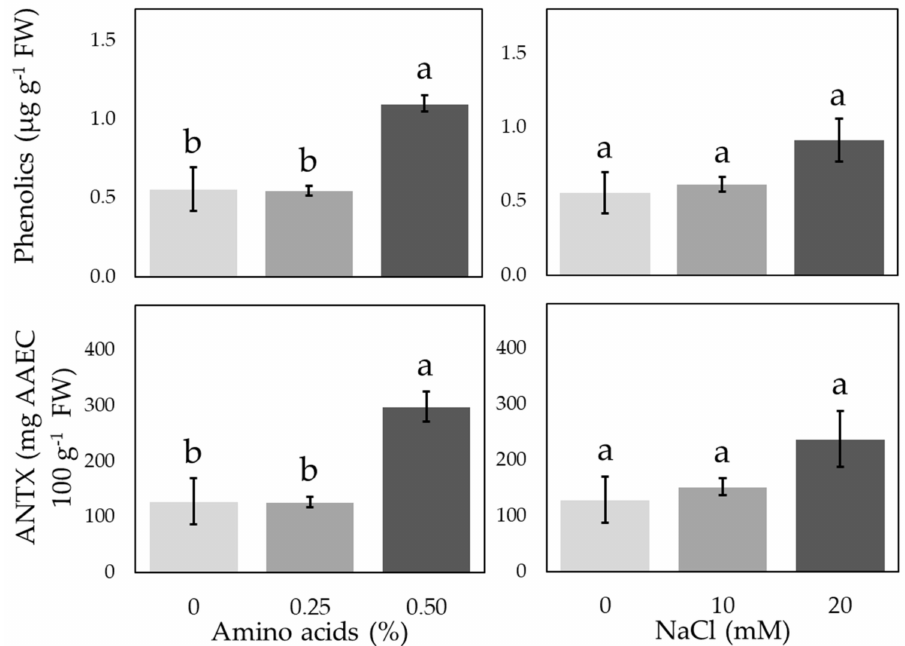
Figure 3. Soluble phenolic content and total antioxidant capacity (ANTX) of spearmint plants grown hydroponically in a floating system on a nutrient solution supplemented either with 0, 0.25 or 0.50% of a commercial amino acid solution (Amino16 ® ) or 0, 10 and 20 mM NaCl. Each column is the mean of 3 replications with 16 plants per replication. Different letters on the columns in each treatment (amino acids or NaCl solution) indicate significant differences between mean, according to the least significant differences test (LSD) at p <